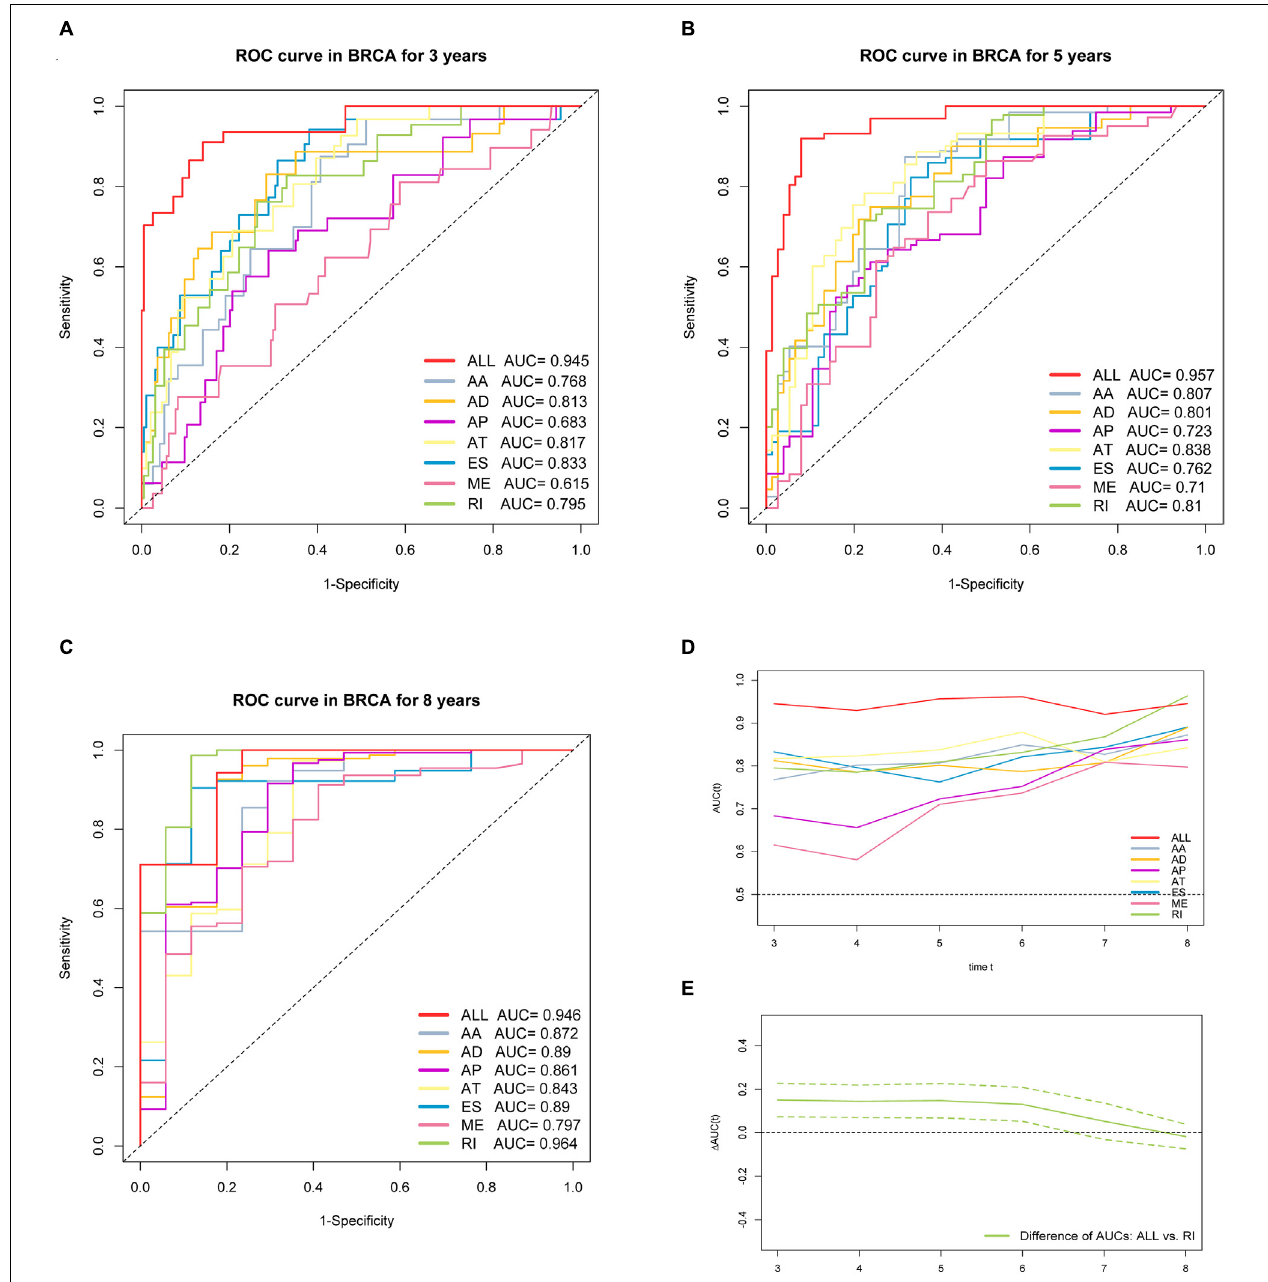
FIGURE 7 | ROC curves with calculated AUCs of prognostic signatures built by either one type or all seven AS types in BRCA cohort for risk prediction in 3 years. (A) 5 years (B) and 8 years (C) , respectively. (D) The curves of time-dependent AUCs versus time (3–8 years) of either each or final signature: AUC(t) versus t. (E) The curve of the difference of time-dependent AUCs between final and RI signature over time (3–8 years): (cid:77) AUC(t) versus t. The color dashed bands indicated the pointwise 95% confidence intervals of estimated AUCs difference. The dashed line evaluates whether the difference of two estimated AUCs at each timepoint is statistical